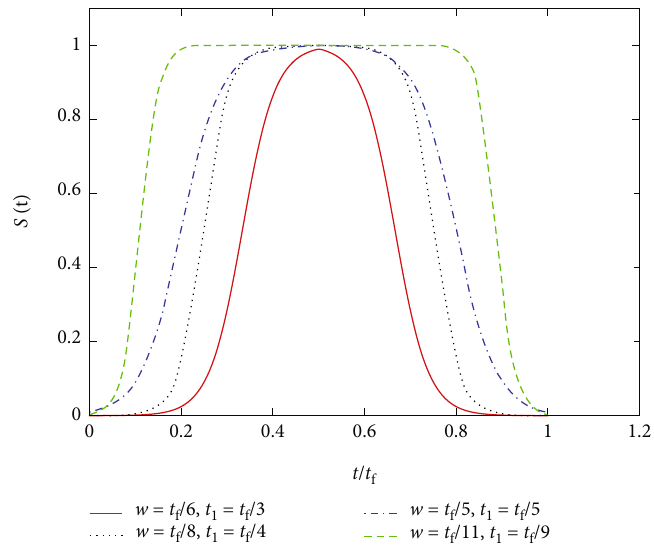
ð t Þ with di ff erent values of w and t 3